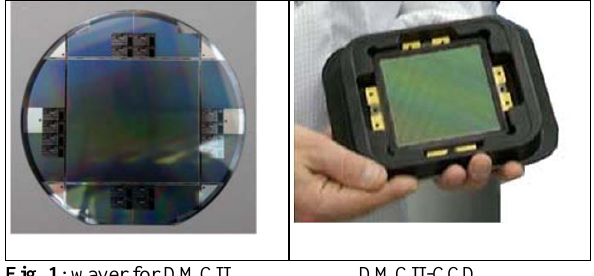
Fig. 1 : waver for DMCII